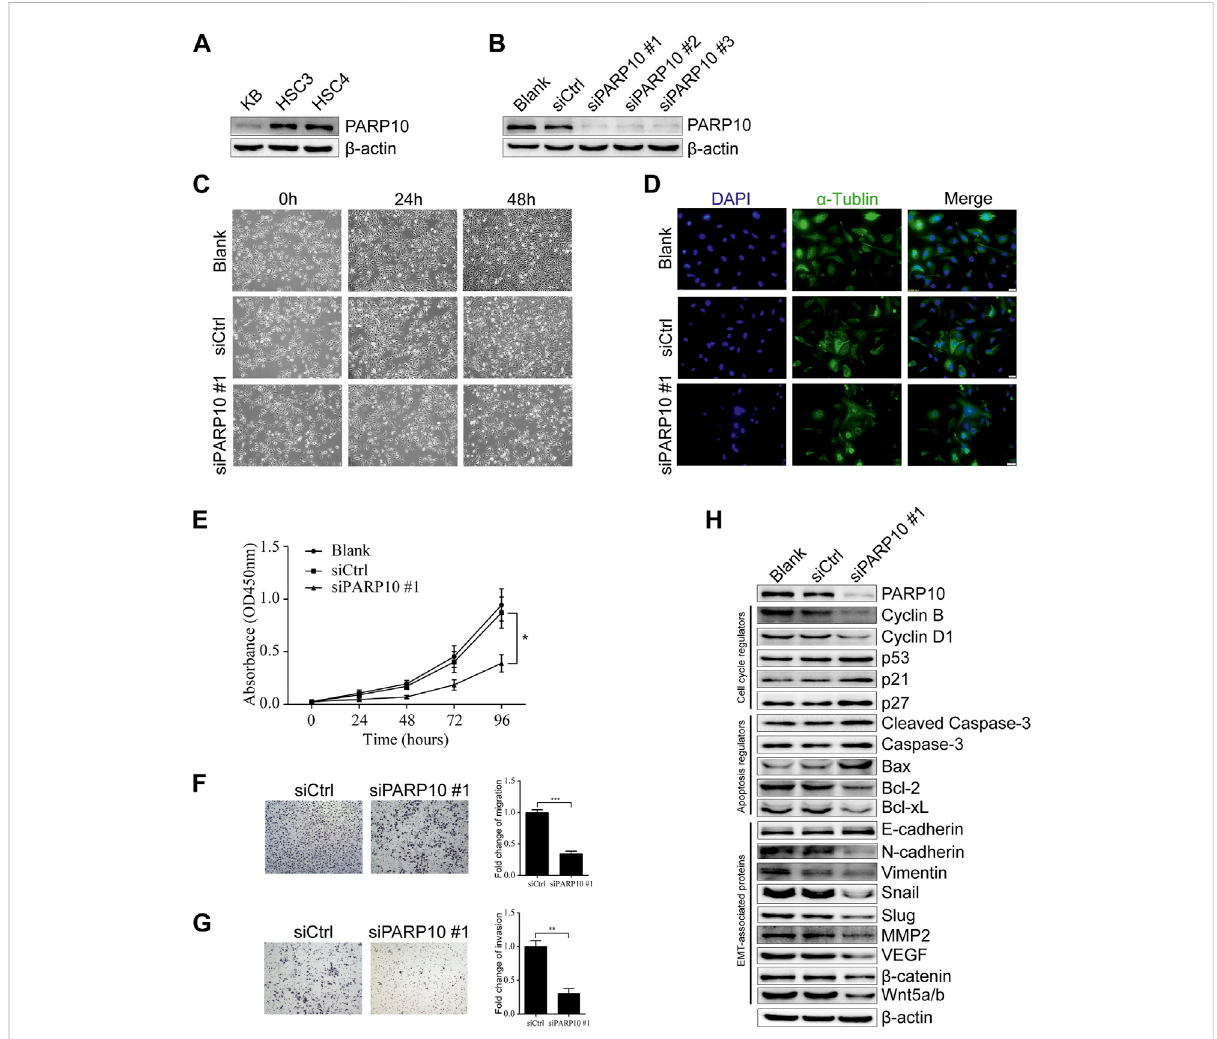
FIGURE 4 Depletion of PARP10 represses growth and metastatic capability in OSCC cells. (A) Western blot analysis of PARP10 in OSCC cell lines. β -actin was used as an internal control. (B) Western blot analysis of PARP10 in HSC3 cells transfected with siRNAs targeting PARP10. β -actin was used as an internalcontrol. (C) MorphologicalimagesofHSC3cellstreatedwithPARP10siRNAattheindicatedtimepoints. (D) Immuno fl uorescenceassayof α - tubulin(green)inHSC3cellstransfectedwithPARP10siRNA.NucleiwerestainedwithDAPI(blue). (E) TheproliferationofHSC3cellstransfected with PARP10 siRNA was monitored by CCK-8 assays at the indicated time points. (F) Migration assay of HSC3 cells transfected with PARP10 siRNA (left). Fold change of migration was quanti fi ed (Right). (G) Invasion assay of HSC3 cells transfected with PARP10 siRNA (left). Fold change of invasion was quanti fi ed (Right). (H) Western blot analysis of the cell cycle regulators, apoptosis-related proteins, and EMT-related proteins in HSC3 cells transfected with PARP10 siRNA. β -actin was used as an internal control. * p < 0.05, ** p < 0.01, *** p <